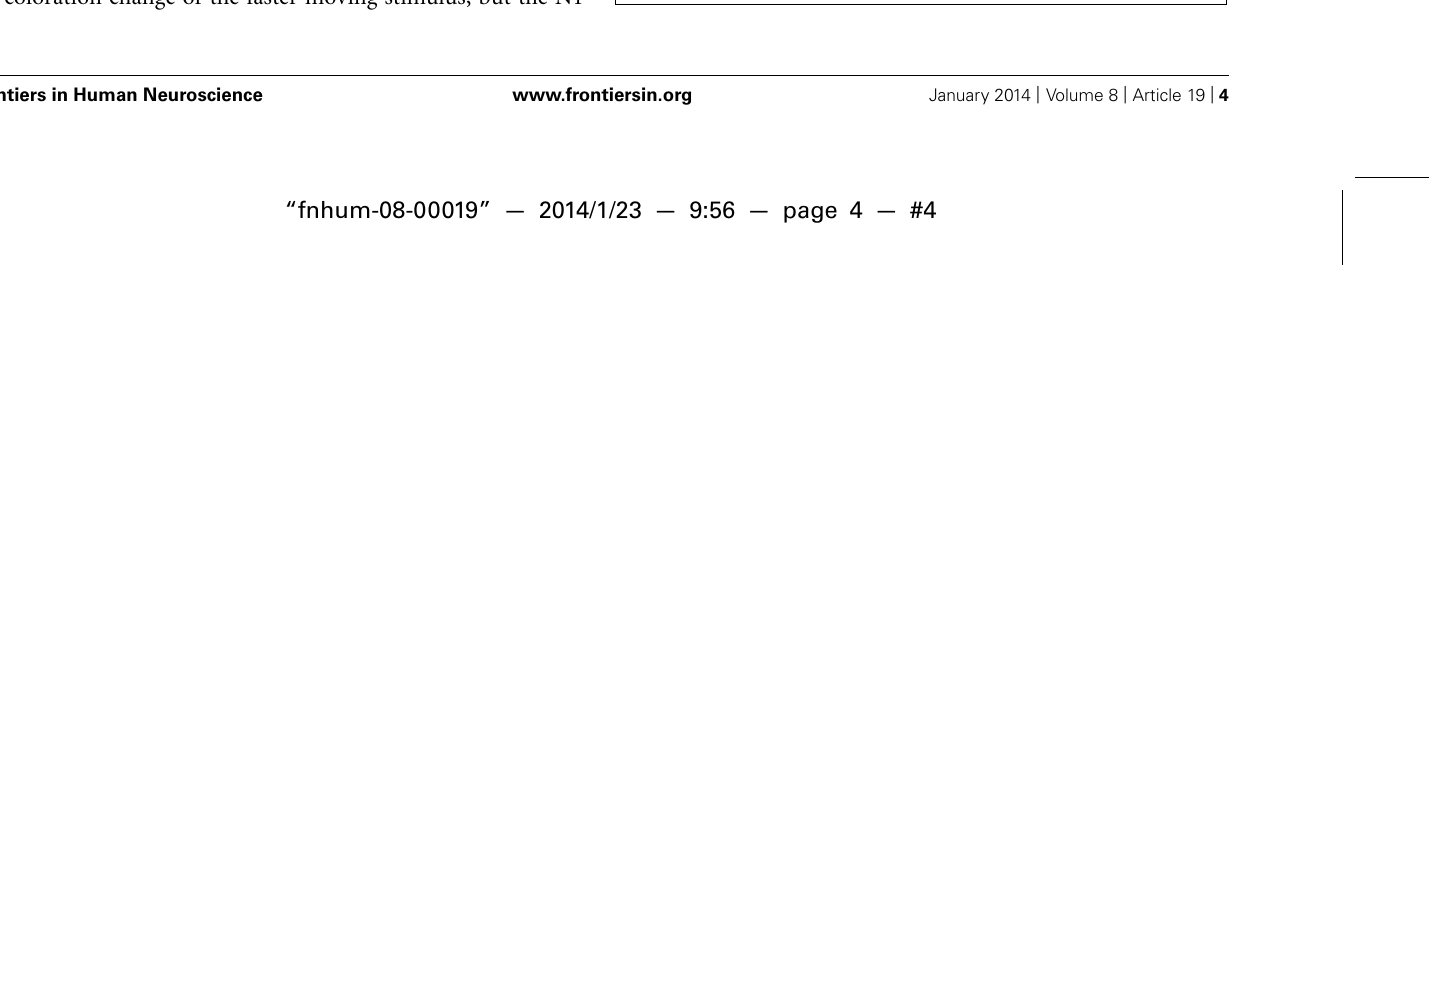
FIGURE 4 |AverageVEPs for the color change in the parietal region by faster and slower moving stimuli (4.4 and 17.6 ◦ /s) for pooled switch-points of the color change (first two switch-points sp1–2, two middle switch-points sp5–6 and last two switch-points